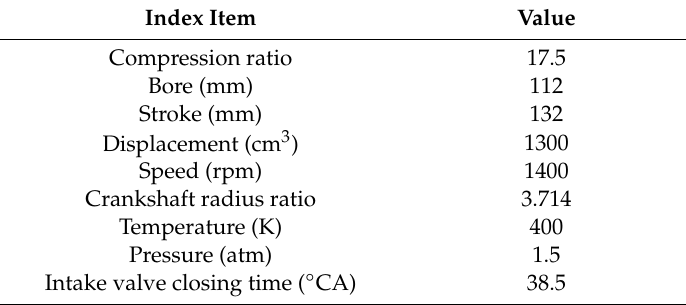
Table 1. Main engine parameters.